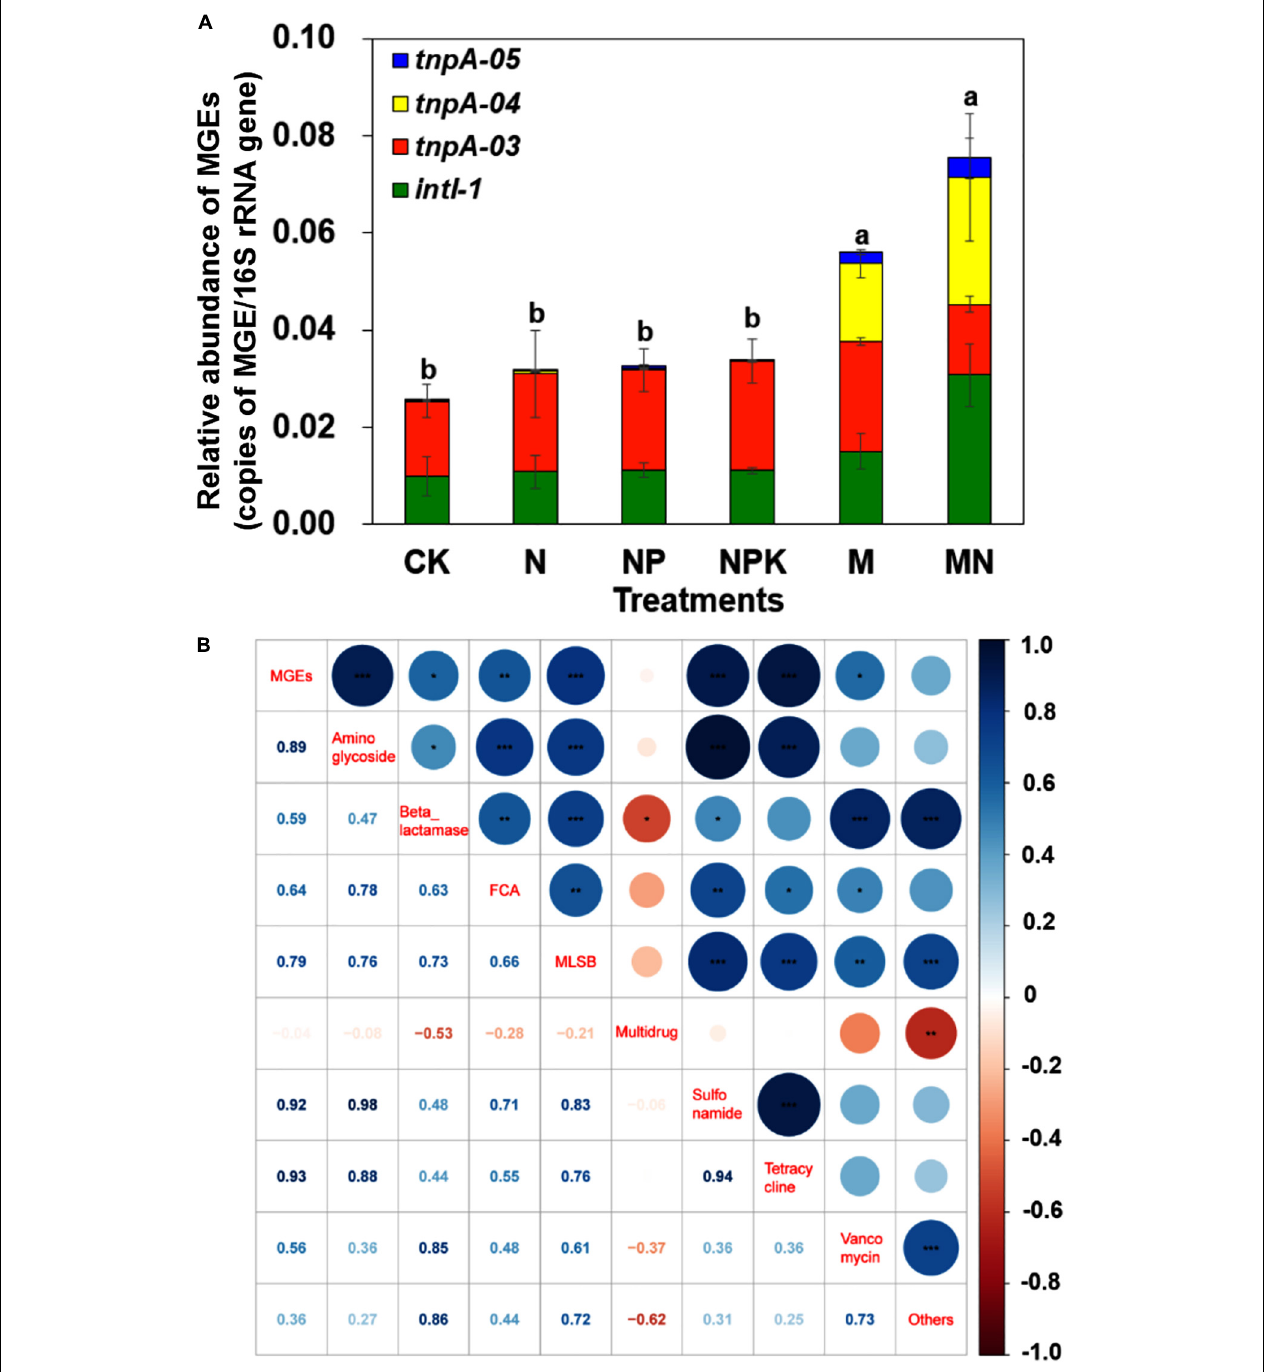
FIGURE 5 | (A) The relative abundance of MGEs in different treatments. (B) Pearson correlation coefficients of the relative abundances of ARGs and MGEs across all treatments. Different letters indicate significant differences of means in pairwise comparisons (Duncan’s test, P < 0.05) for each treatment.